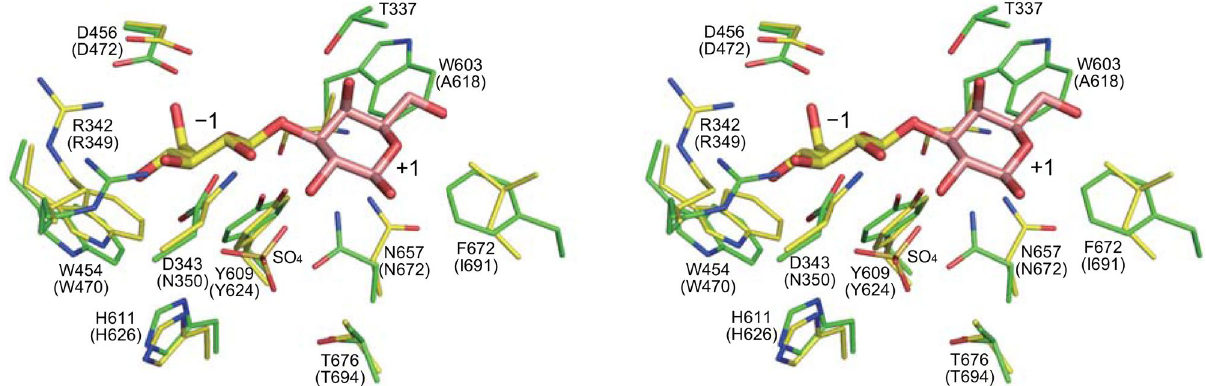
Figure 6. Predicted structure of PBOR_28850. Structure of PBOR_28850 was predicted by AlphaFold 26 . The model structure of PBOR_28850 (green) is superimposed onto S. degradans CBAP in complex with 3- O -β-d- glucopyranosyl-α-d-glucopyranuronic acid (yellow; PDB entry, 4ZLI). To predict the binding mode of solabiose in PBOR_28850, β-d-galactose in ideal form (PDB entry, GAL), shown in pale orange, is overlapped onto the α-d-glucopyranuronic acid residue (α-d-glucopyranuronic acid residue is not